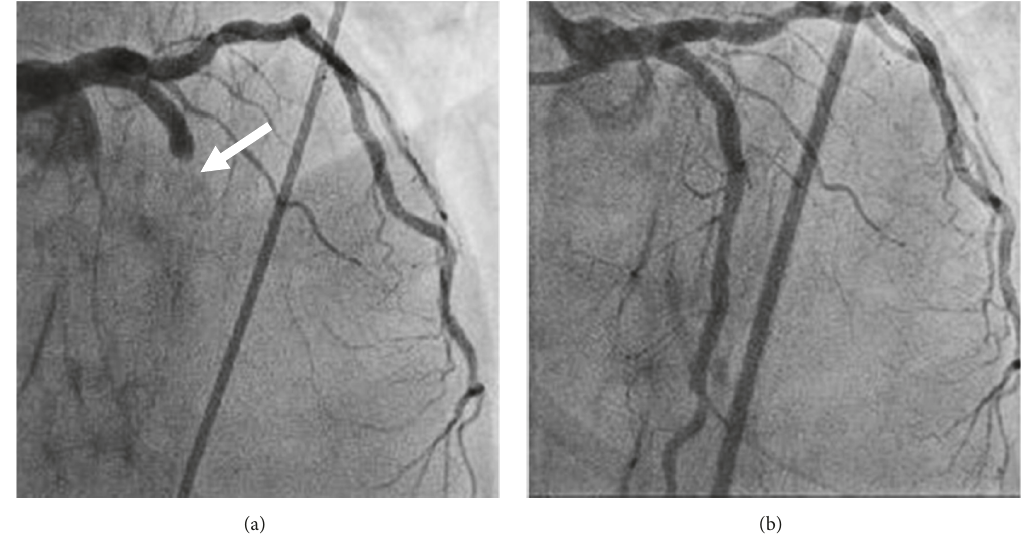
Figure 5: Coronary angiogram at the time of myocardial infarction (a) and after endovascular intervention (b). Angiogram at the time of myocardial infarction (a) showing occlusion of the left anterior descending artery with thrombus.